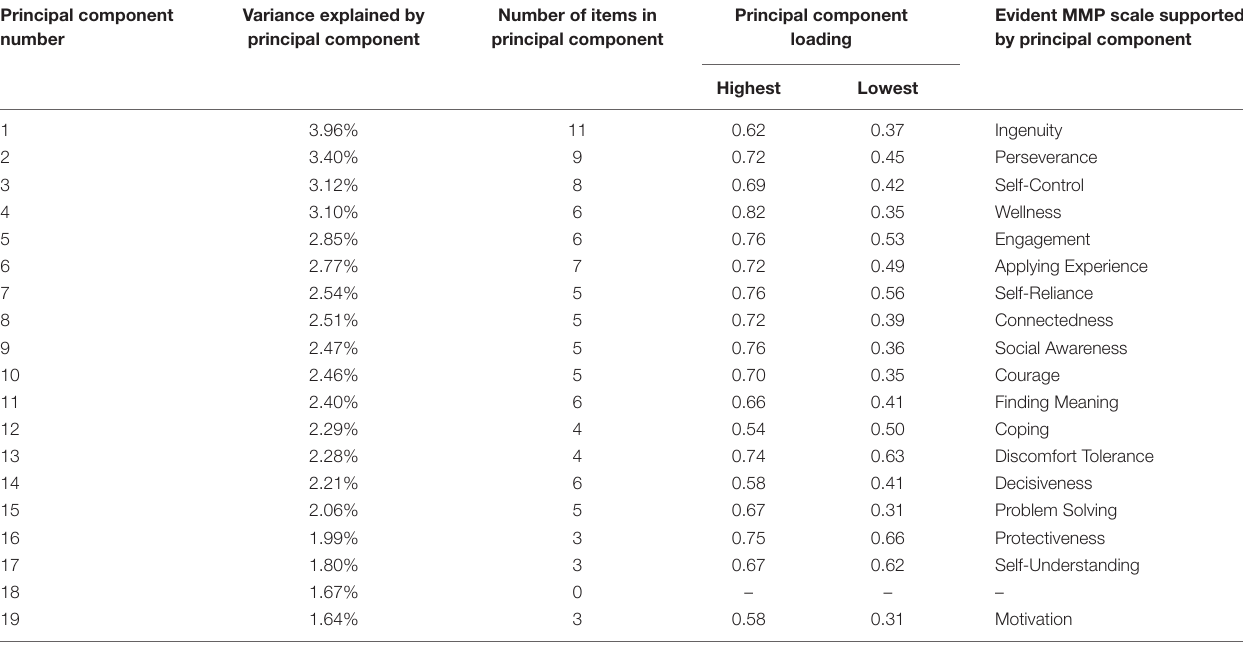
TABLE 1 | Summary of PCA results in support of the MMP 18-factor structure ( n =3,039). Principal component number